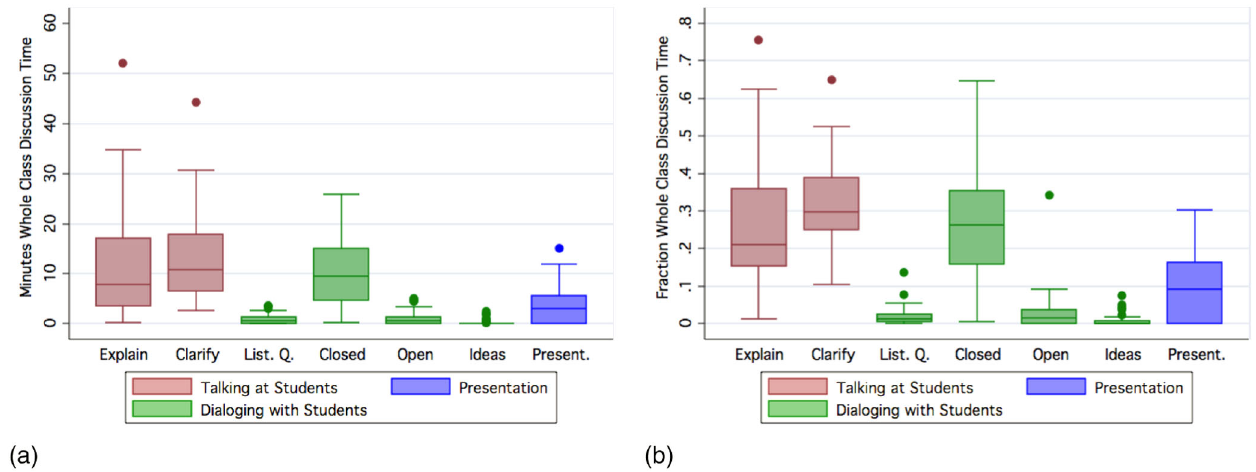
FIG. 5 (color online). Breakdown of whole class discussion time. (a) The number of minutes of WCD time dedicated to each type of interaction. (b) The percentage of WCD time in each type of